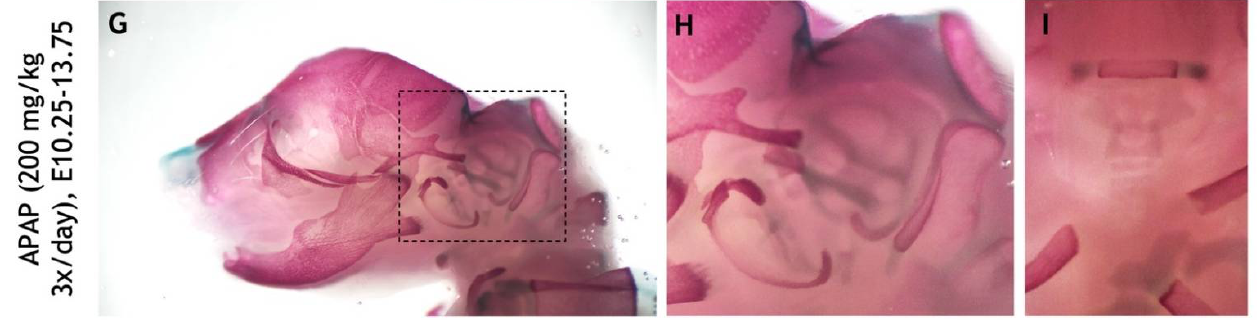
Figure 9. Repeated administration of high APAP dosage to pregnant mice does not recapitulate craniofacial defects. ( A – I ) Pregnant dams were administered via oral gavage three times daily: Saline between E10.25–13.75 ( A – C ), 200 mg/kg APAP between E7.25–10.75 ( D – F ), 200 mg/kg APAP between E10.25–13.75 ( G – I ). The resulting pups were collected at P0 and stained with alcian blue (cartilage) and alizarin red (bone). ( A – C ) A control pup with pertinent bones and cartilages labeled. Pharyngeal arch-derived structures are indicated with parentheses (e.g., “p1” = derived from the first pharyngeal arch). ( D – F ) In a pup whose mother was treated with APAP between E7.25–10.75, all labeled structures develop normally. ( G – I ) No defects seen in a pup whose mother was treated with APAP between E10.25–13.75. Dashed boxes in ( A , D , G ) are the fields of view for panels ( B , E , H ), respectively. Abbreviations: cricoid cartilage, Cri; hyoid, Hyo; incus, Inc; malleus, Mal; mandible, Man; stapes, Sta; styoid process of the temporal bone, Sty; thyroid cartilage, Thy; tracheal cartilages, Tra; tympanic, Tym. Scale bars in ( A – C ), 1 mm.